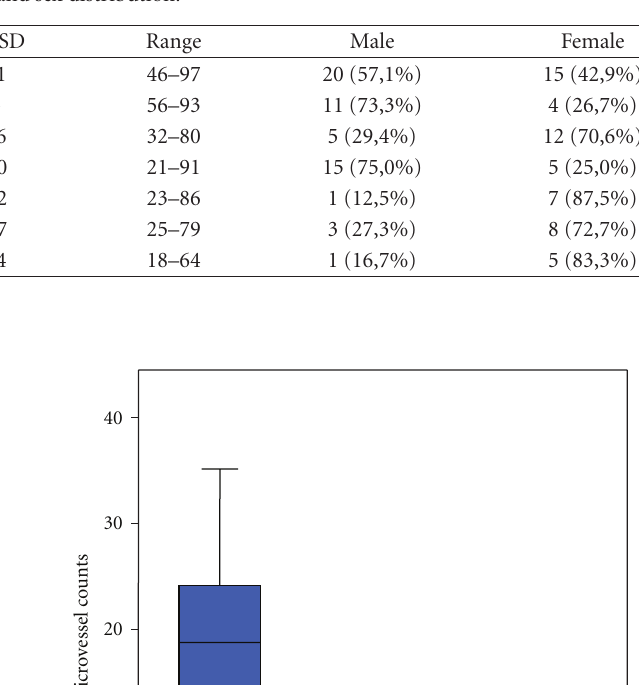
Table 1: Age and sex distribution.